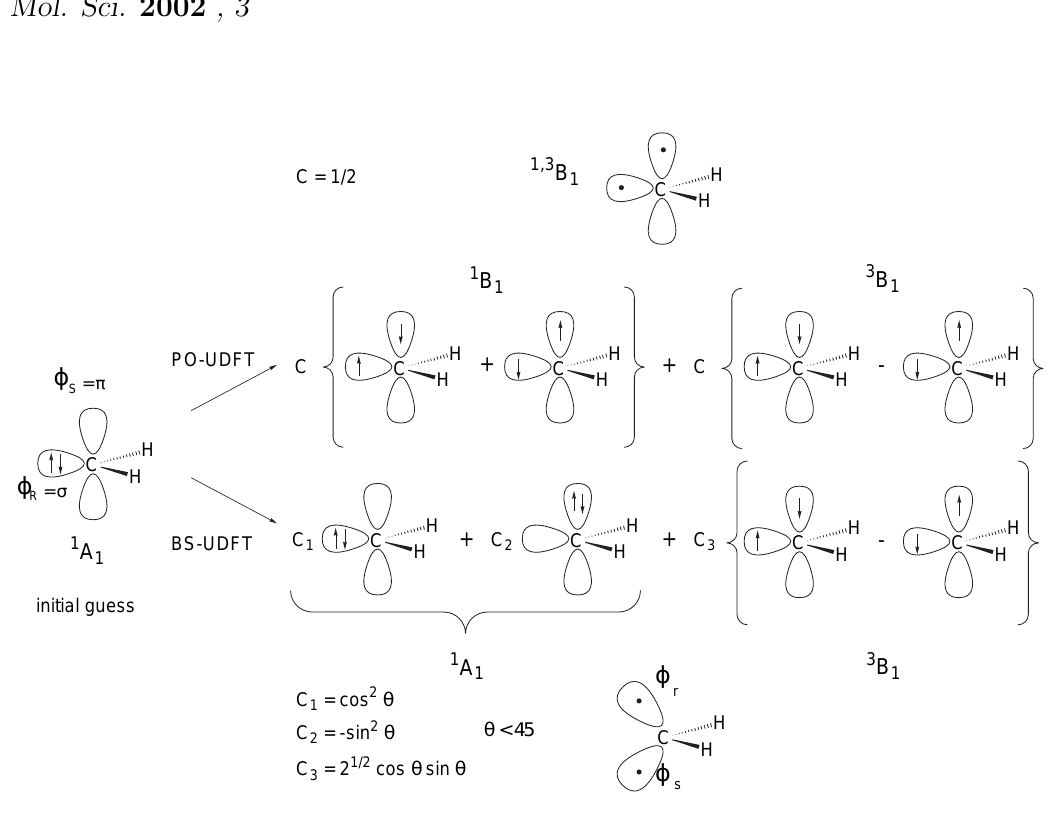
Figure 2b: Schematic representation of the construction of PO-UDFT and BS-UDFT wave func- tion in the case of 1 . The changes in the orbital form are indicated at the top (PO-UDFT) and at the bottom